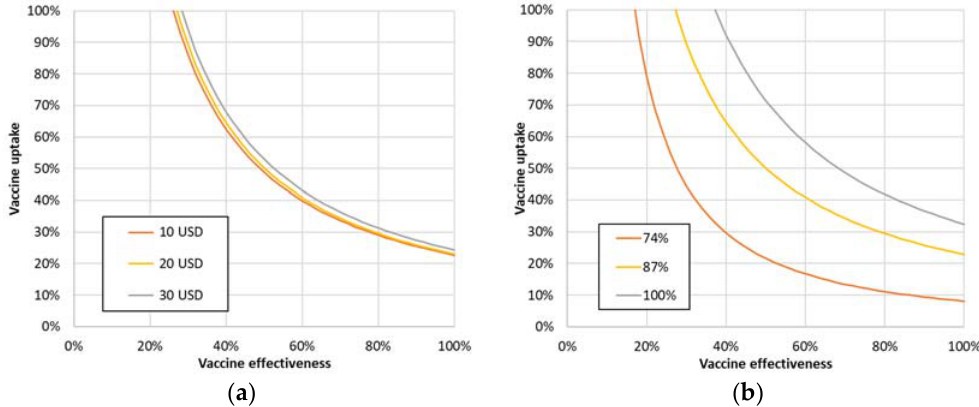
Figure 4. ( a ) Iso ‐ ICER cost ‐ effectiveness curves at one GDP/capita for 10, 20 (baseline), and 30 USD costs of vaccination. ( b ) Iso ‐ ICER cost ‐ effectiveness curves at one GDP/capita for 74%, 87% (baseline), and 100% susceptibility.